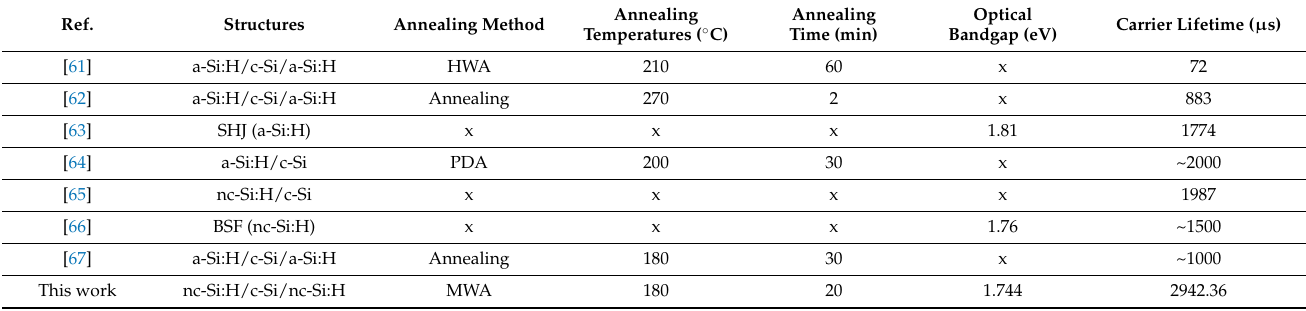
Figure 10. Carrier lifetime of the thin film (symmetric structures) after microwave annealing. In all cases, the c-Si substrate size was 2.5 cm 2 , the MWA power was 440 W, the annealing temperature was 180 ◦ C, and the MWA time was 20 min. Table 2. Comparison of carrier lifetime, annealing method, annealing temperatures, and annealing time performance between the previous research and the current study. Note: a-Si:H = amorphous silicon; c-Si = crystalline silicon; HWA = high-pressure water-vapor annealing; MWA = microwave annealing; x = not reported in the reference; PDA = post-deposition annealing; SHJ = silicon hetero junction; BSF = back surface field.